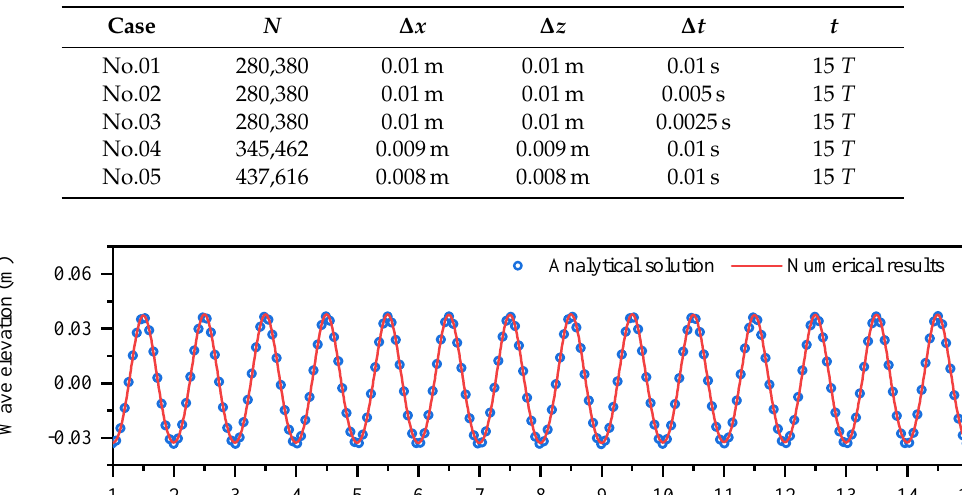
Table 1. Numerical parameters of numbers total nodes N , spaces of nodes along x and z axes ( ∆ x and ∆ z ), time increment ( ∆ t ) and the simulation duration ( t ) of five cases for the validation of convergence and stability.